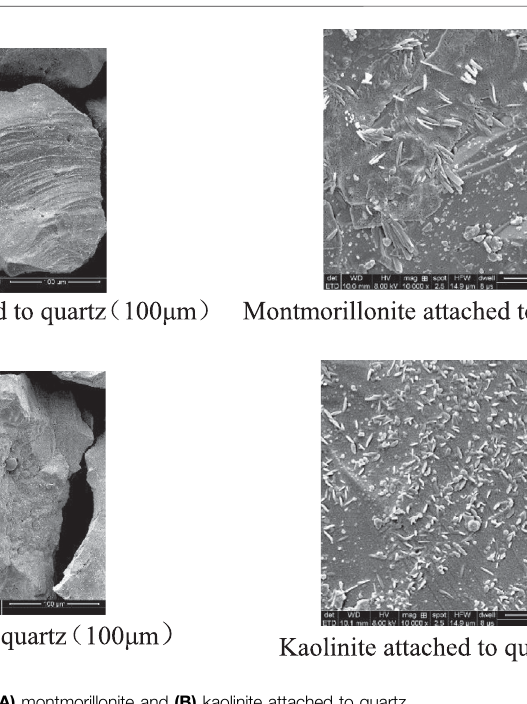
Frontiers in Energy Research |